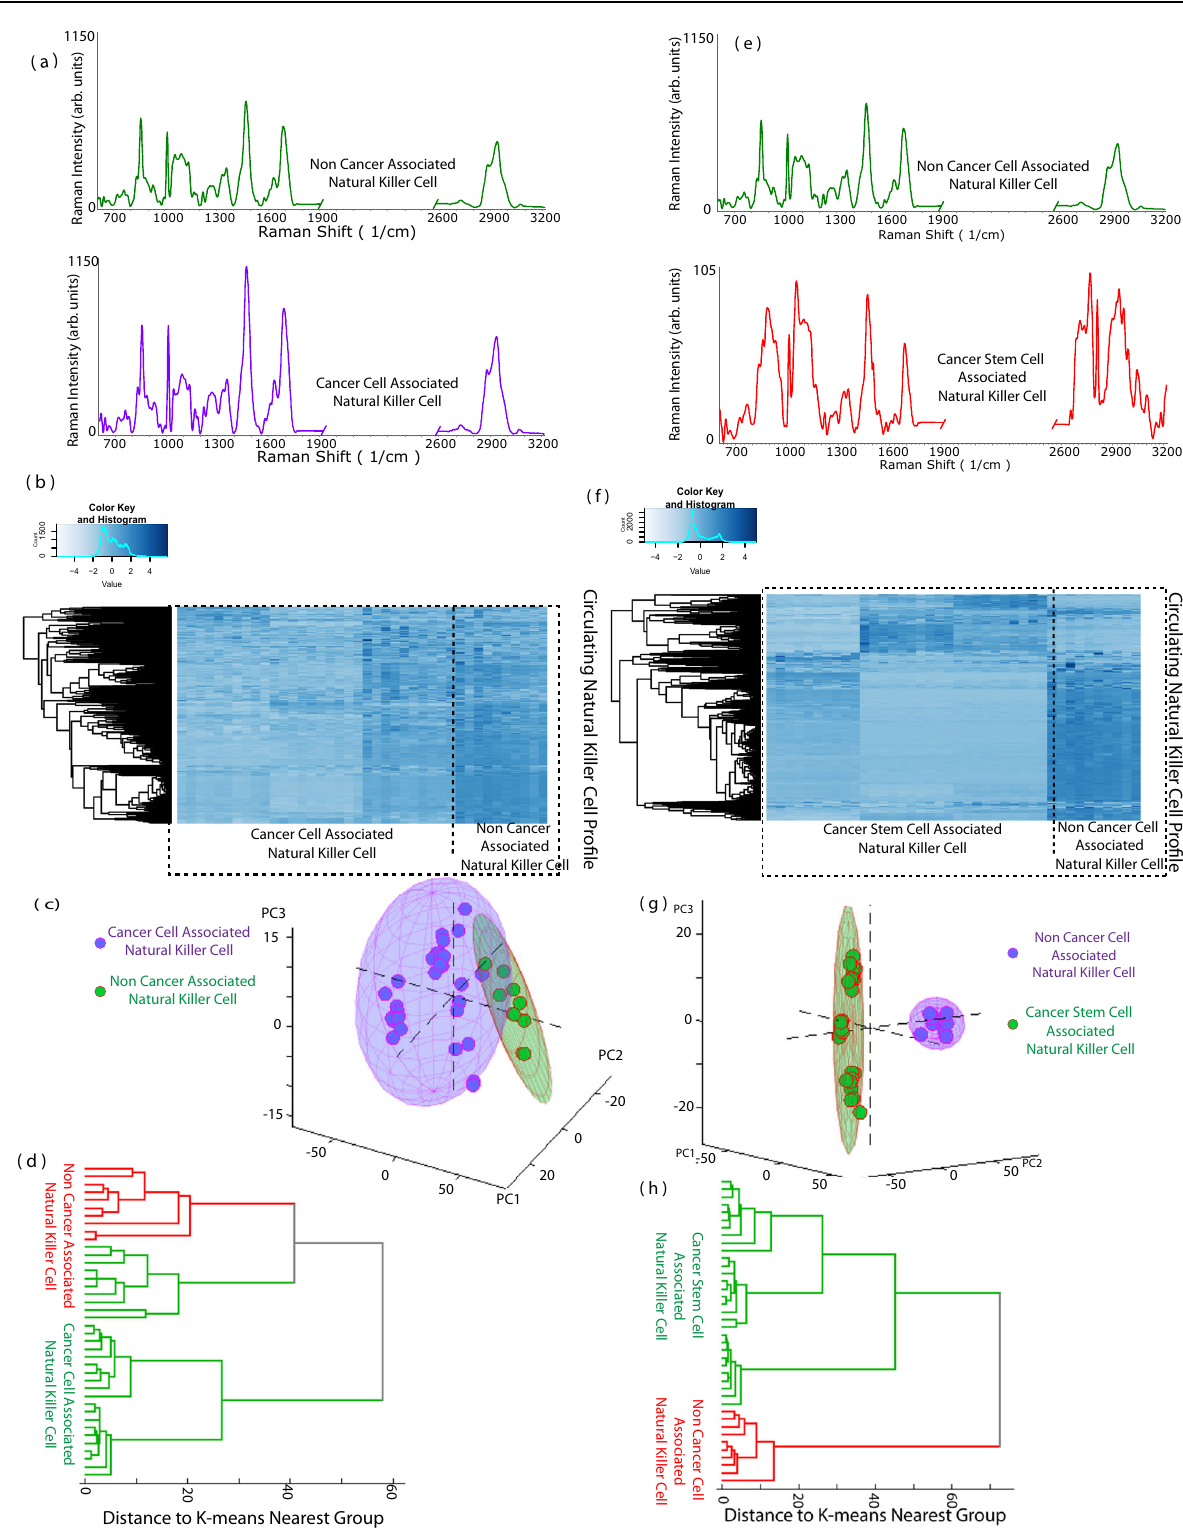
Fig.6|Variationinthesignalsofcancer-associatedNKcell,CSC-associatedNK cell and non-cancer-associated NK cell. a Representative Raman spectra of non- cancer-cell-associatedNKcells(green)andcancer-cell-associatedNKcells(purple). b Heatmap of cancer-associated NK cell and non-cancer-associated NK cell. c Principalcomponentanalysisshowsoverlapbetweentheclusters. d Dendrogram ofthedistanceforK-MeansnearestgroupdemonstratedmixedNKCellassociation